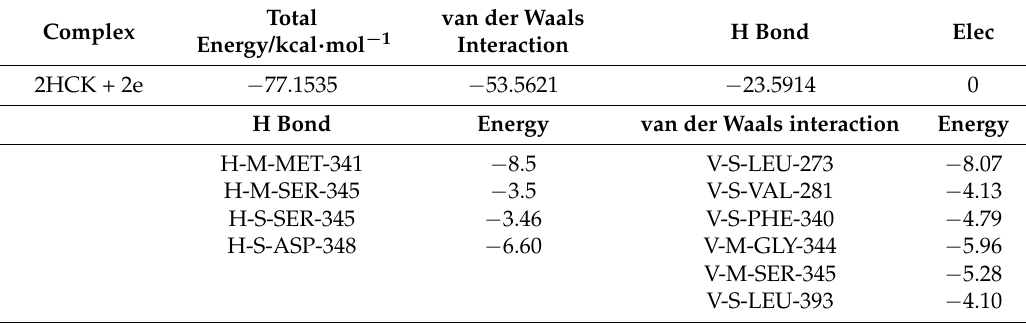
Table 3. Docking score and energy of the interactions between protein residue and ligand 2e